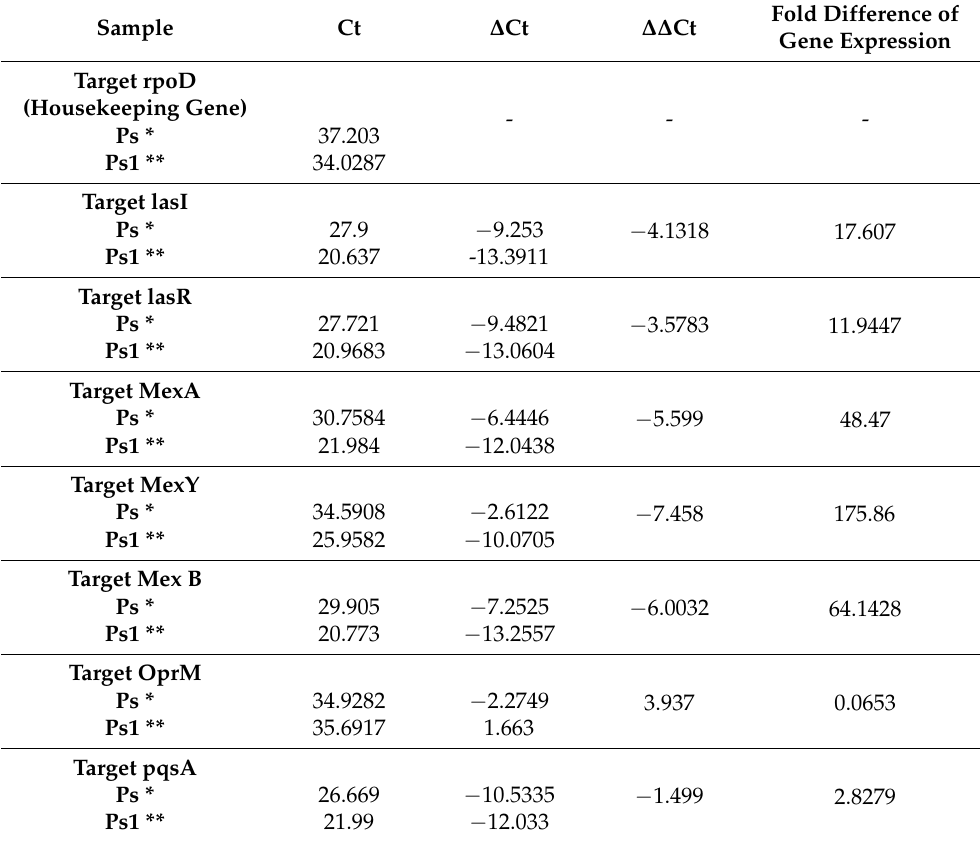
Table 6. Relative quantitation of gene expression of treated and control P. aeruginosa isolate.